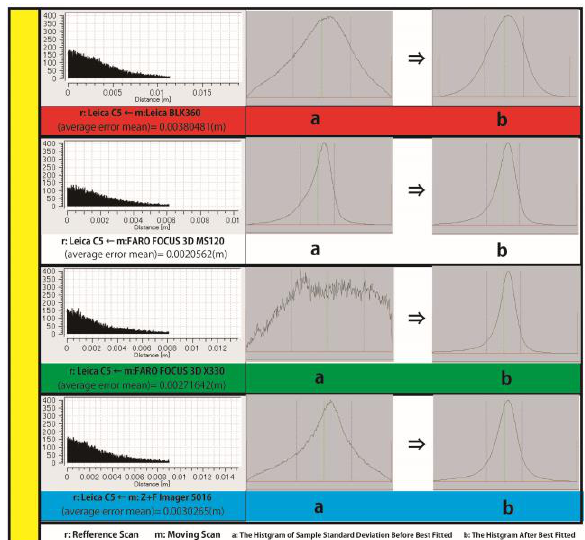
Figure 8: The Results of Aligning (Refference:FARO Focus 3D X330), (3D Recnstructor and IMAlign were used)